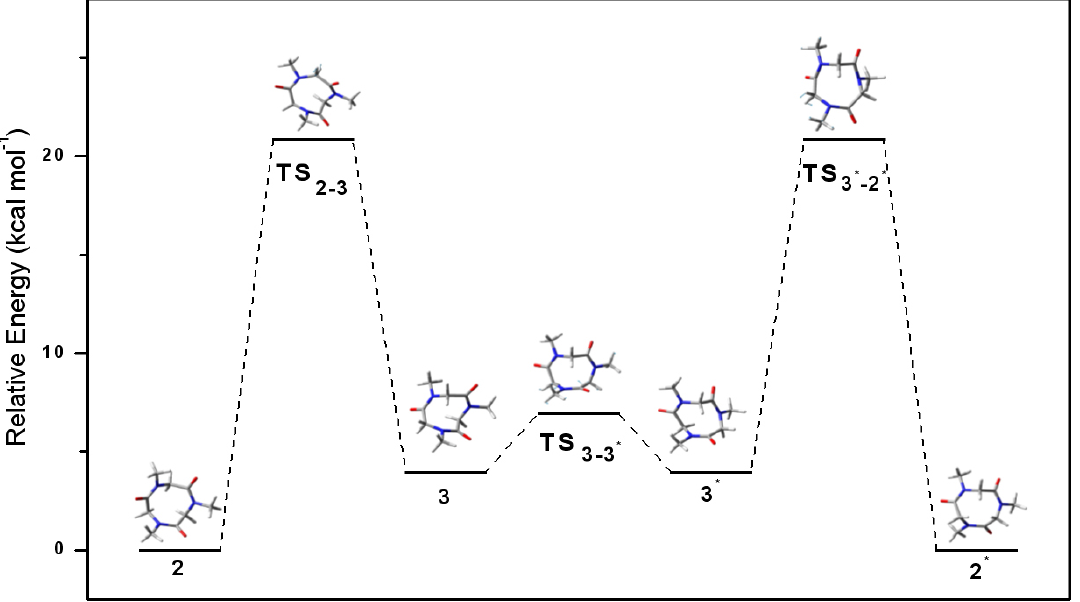
Figure 5. The energy profiles in kcal mol -1 obtained from MP2/6-31G(d,p)//B3LYP/6-311++G(d,p) calculations for the enantiomeric 2-2* interconversion. Spatial views of the minima and TSs involved in these interconversion are also shown